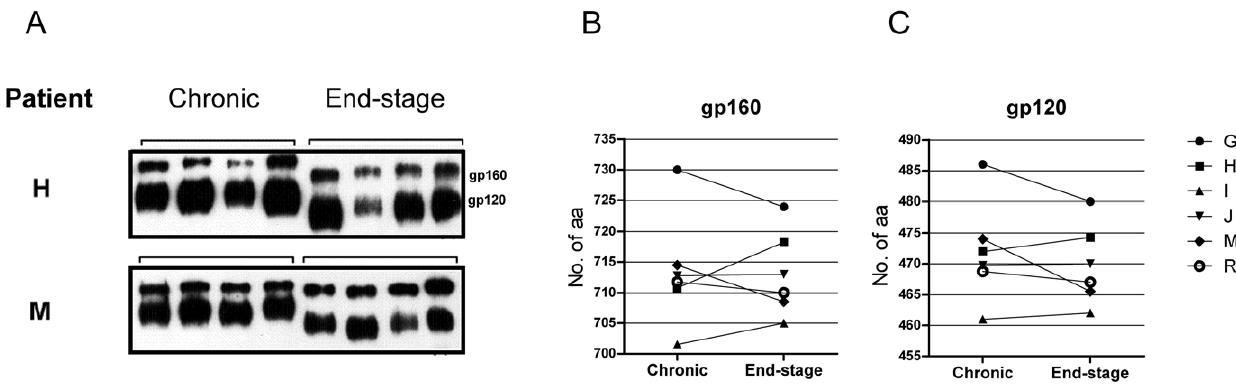
Figure 4. Molecular weight and peptide backbone length of Env from sequential HIV-1 R5 viruses. a) Mobility in SDS-PAGE gel of gp120 and gp160 clones from R5 HIV-1 isolates as assessed by Western Blot. The results of four Env clones for each R5 isolate obtained during chronic and end-stage disease from patients H and M are illustrated. Differences in amino acids sequence length of b) gp160 and c) gp120 comparing the average amino acids length of four R5 Env sequences per isolate obtained longitudinally at the chronic phase and at end-stage disease.